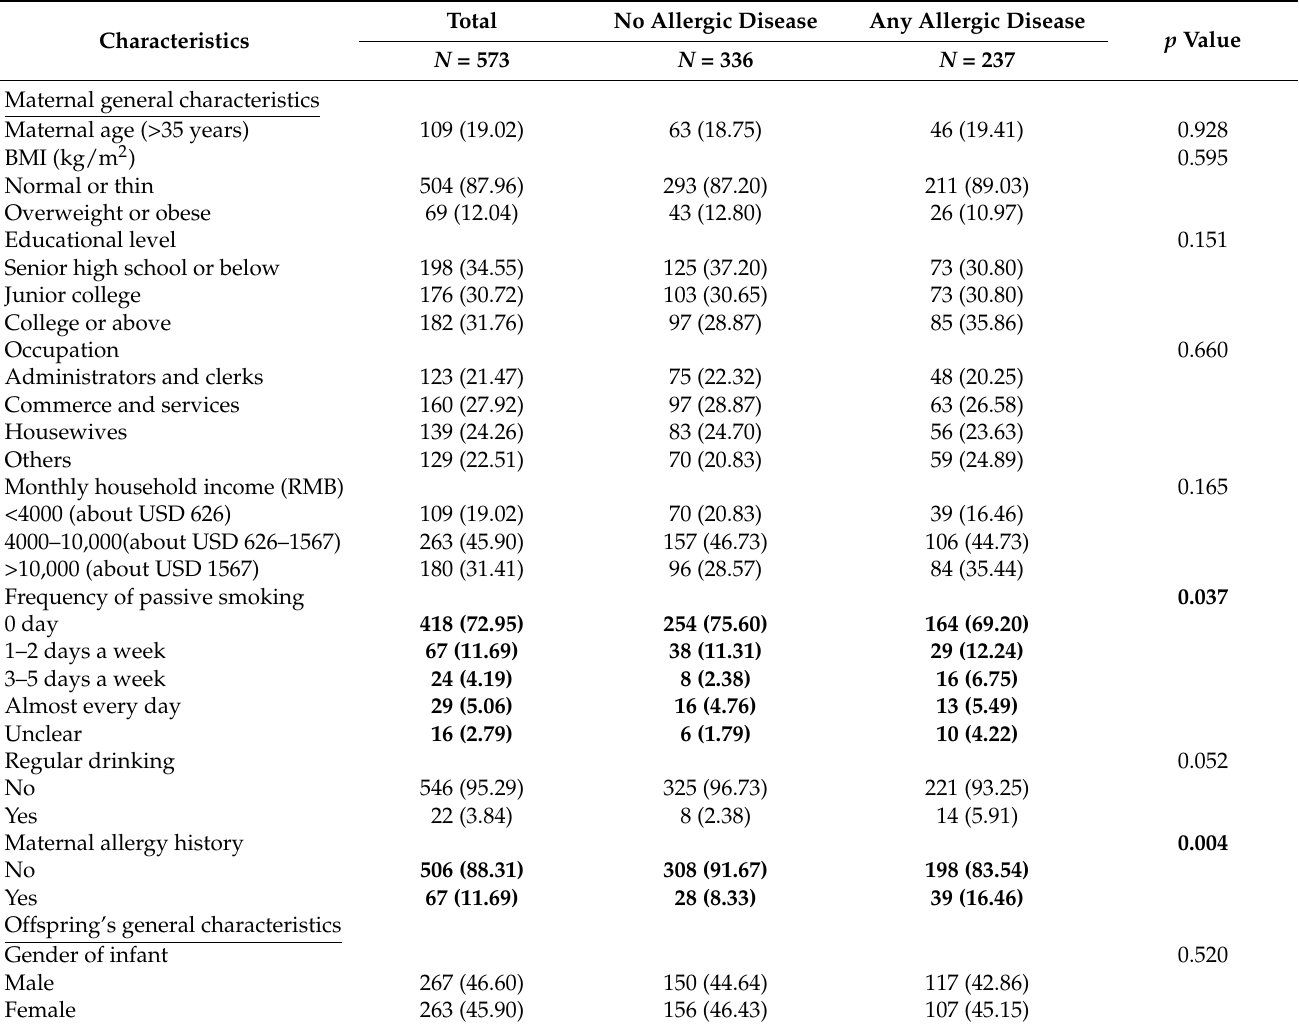
Table 1. Characteristics of the study population (n,